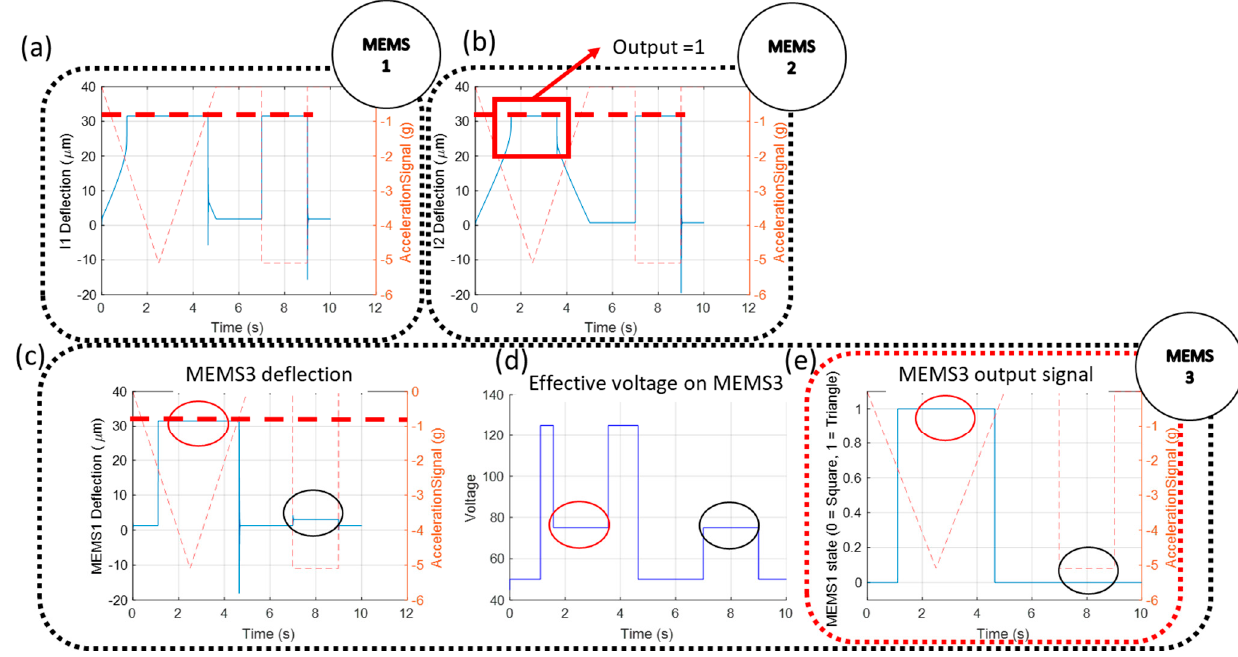
Figure 7. Classification test results showing the response of MEMS1 ( a ), MEMS2 ( b ) and MEMS3 ( c ). ( d ) The effective voltage acting on MEMS3 V 3 ( t ) . ( e ) The state of MEMS3 when subject to a triangle or a square